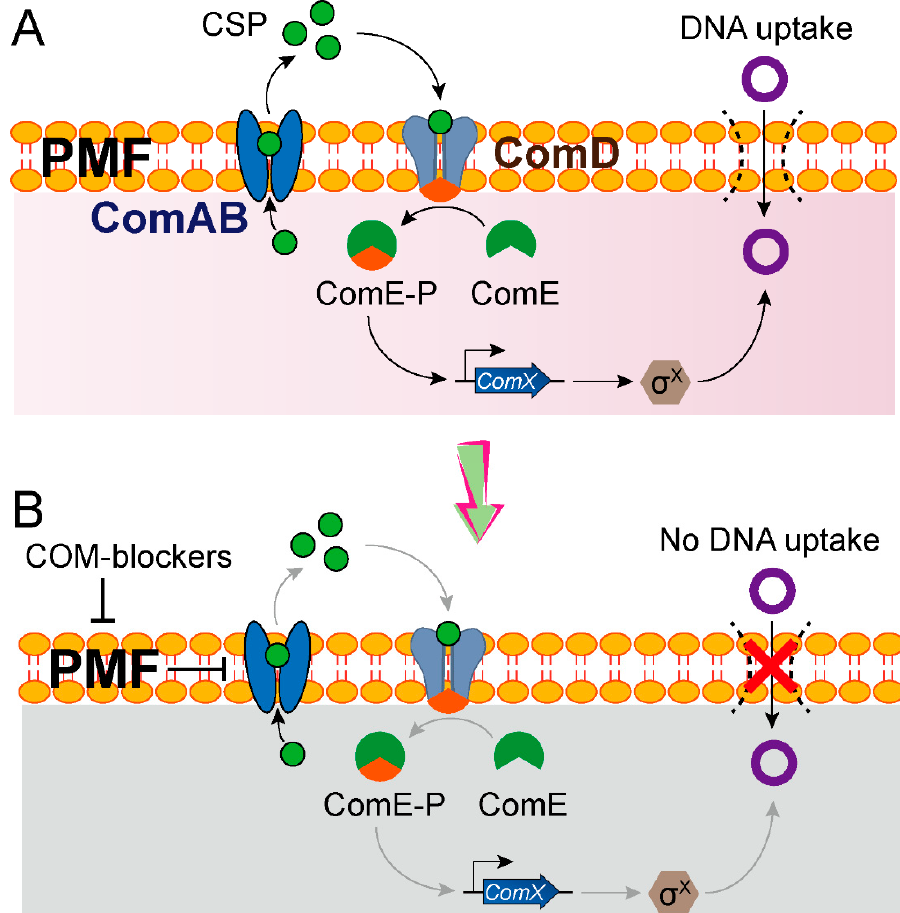
Figure 4. COM-blockers limit the HGT in S. pneumoniae by inhibiting the proton motive force (PMF) [84]. ( A ) Overview of the competence-dependent regulatory mechanism of HGT in S. pneumoniae . The membrane transporter ComAB first exports competence-stimulating peptide (CSP) with the aid of proton motive force (PMF). Then, CSP binds to histidine-kinase ComD, which accounts for the transfer of phosphate group to the downstream response regulator ComE. Phosphorylated ComE, in turn, promotes the expression of SigX encoded by comX , which is responsible for the uptake of exogenous DNA. ( B ) COM-blockers, including the biocide triclosan, the antimalarial proguanil hydrochloride and the antipsychotic pimozide, displayed the ability to inhibit PMF and block the secretion of CSP, thereby preventing the uptake of DNA and HGT.